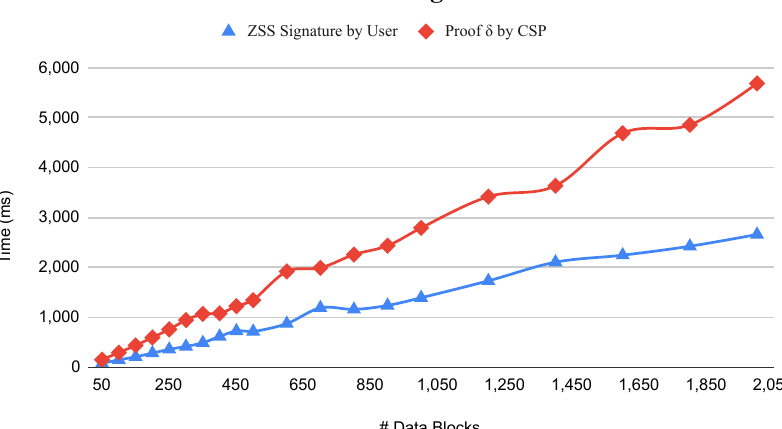
Figure 5. Generation time of Signature and Proof